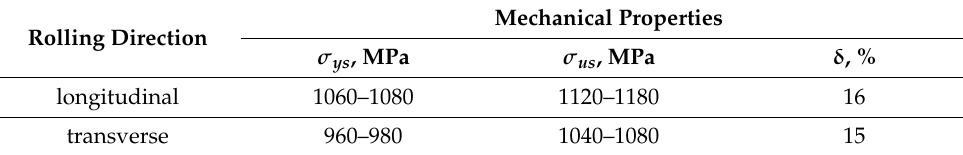
Table 1. The mechanical properties of titanium alloy VT23 depend on the rolling direction.